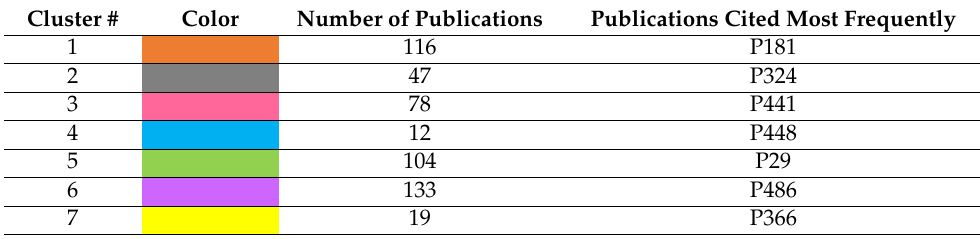
Figure 15. Community detection of citation networks.